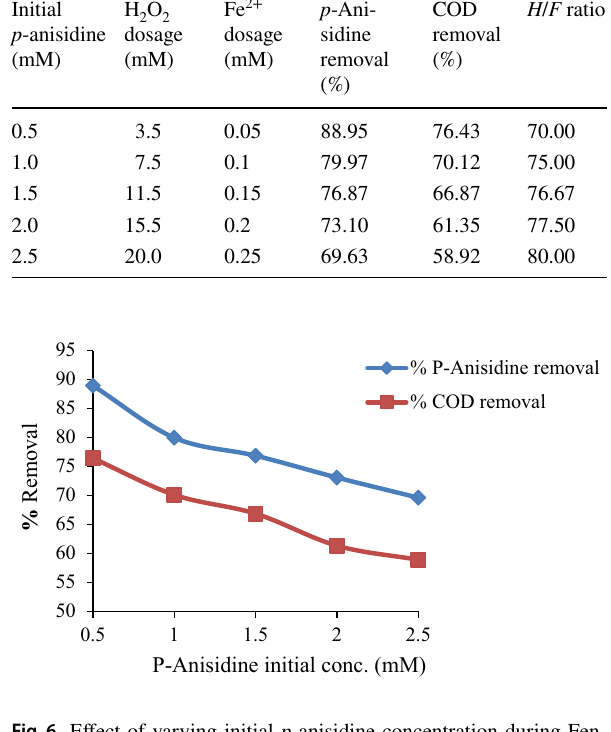
Table 2 Fenton’s treatment of p -anisidine at varying initial concentra- tion Initial p -anisidine